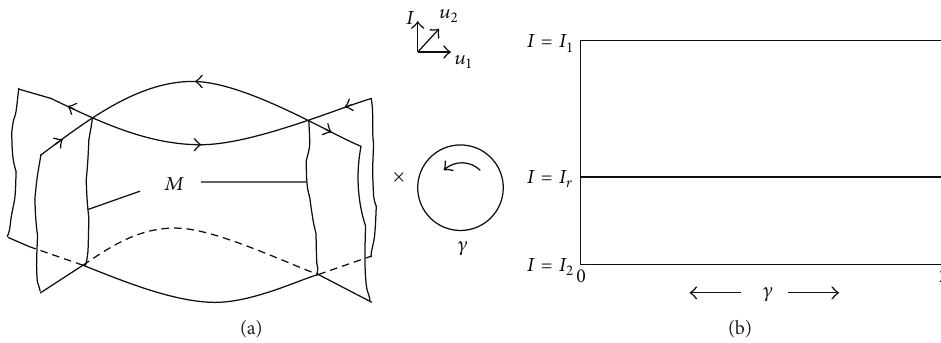
Figure 2: The geometric structure of manifolds 𝑀 ; 𝑊 𝑠 (𝑀) and 𝑊 𝑢 (𝑀) are given in the full four-dimensional phase space.